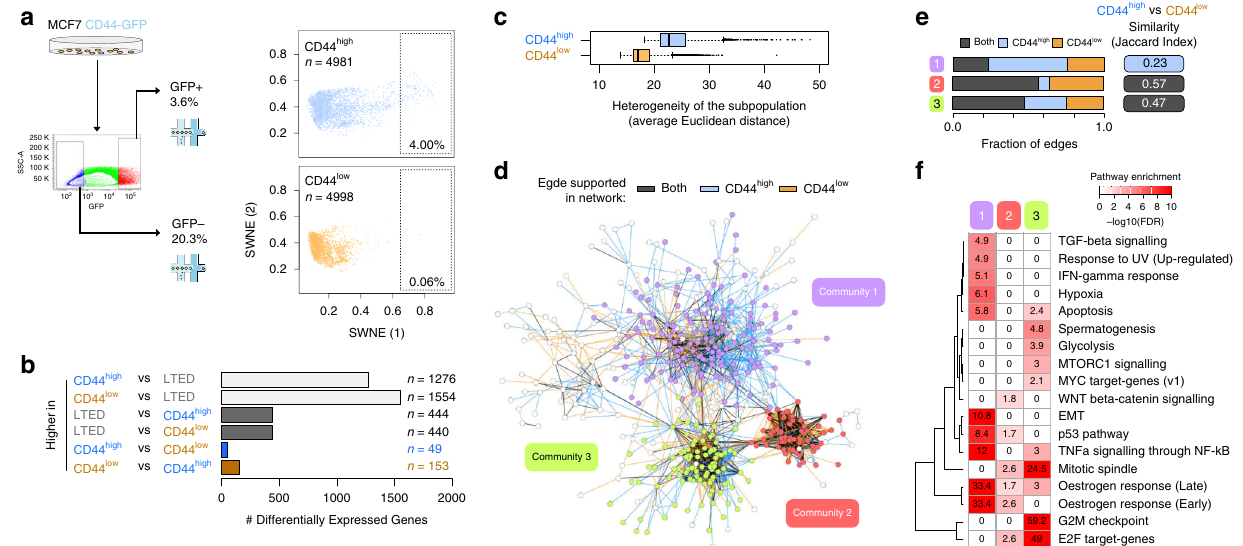
Fig. 3 Single-cell transcriptomics reveals heterogeneity of plastic cells. a Schematic representation of the strategy to sort MCF7-CD44 GFP-high (CD44 high ) and MCF7-CD44 GFP-low (CD44 low ) cells (left) along with the results of dimensionality reduction for single-cell transcriptomes (right) (SWNE, k = 22); percentage of extreme outliers in the two subpopulations indicated in the bottom right corner. b The number of upregulated genes in the indicated comparisons ( q -value < = 0.05; AUC > = 0.6). c Cell – cell heterogeneity within CD44 high and CD44 low subpopulations. Box plots show median, interquartile values, range and outliers (individual points). d Regulatory networks reconstructed using either CD44 high and CD44 low pro fi les were superimposed and the edges colour-coded according to whether each edge was identi fi ed only in the CD44 high (blue), the CD44 low (orange) or both (dark grey) networks. Nodes in the three larger communities were colour-coded accordingly. e Fraction of edges identi fi ed in the CD44 high , the CD44 low or both networks, for each one of the three communities shown in ( d ). Similarity between CD44 high and CD44 low networks is also shown. f Enrichment analysis using the hallmark gene sets 38 across the three communities shown in ( d